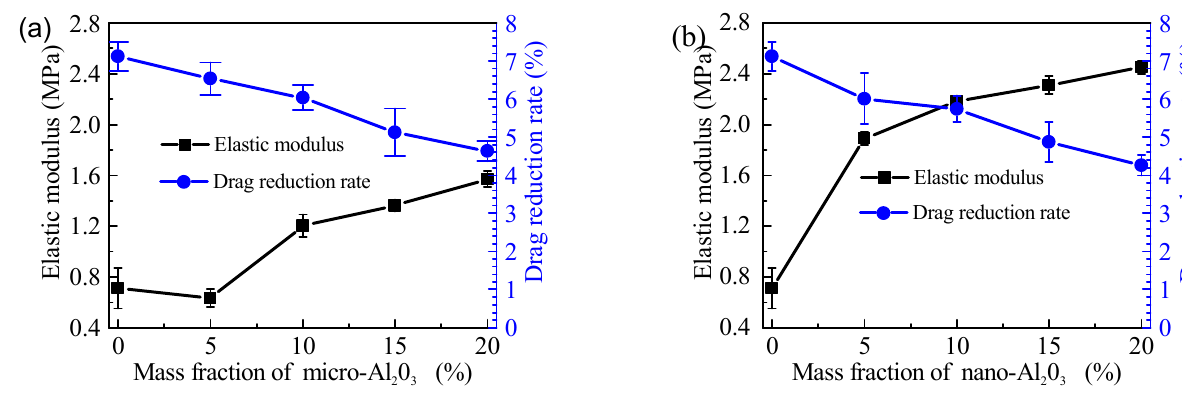
Figure 12. Elastic modulus and drag reduction rate of studied samples at 1400 rpm: ( a ) Micro-alumina, ( b ) Nano-alumina.